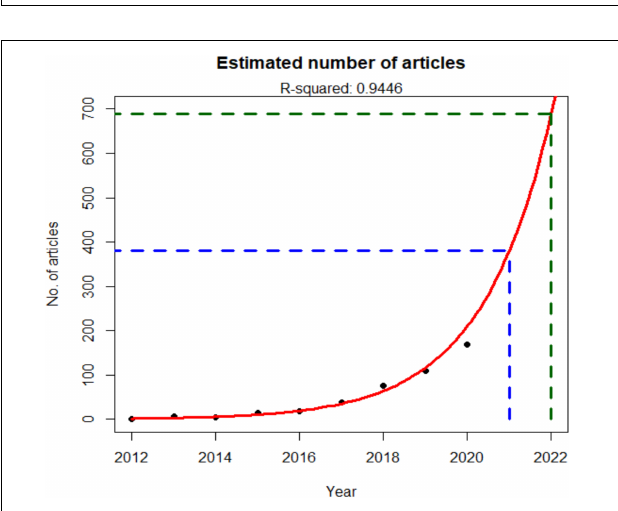
FIGURE 2 | Year-wise distribution of the Scopus documents in 2012–2021.